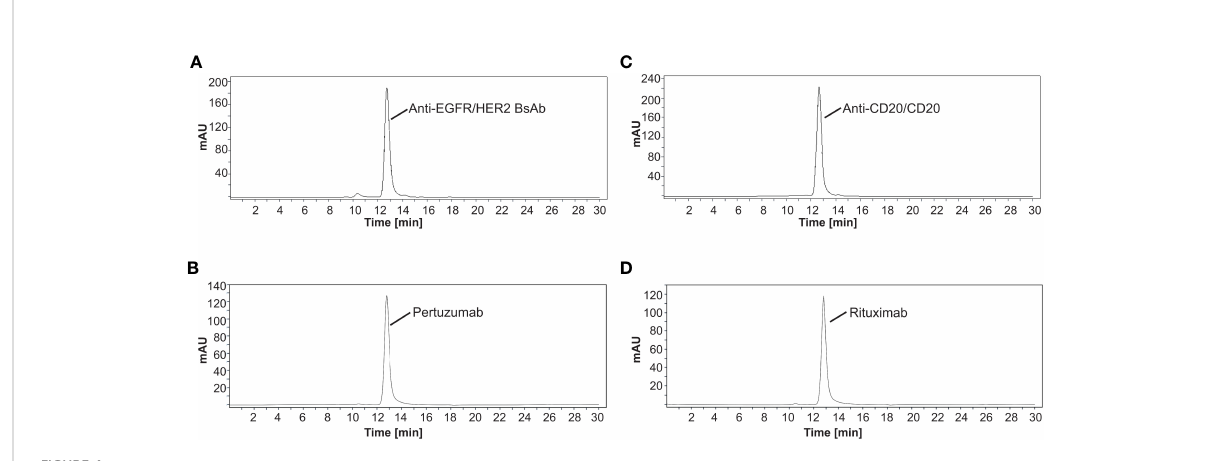
FIGURE 4 Separation of antibodies by size exclusion chromatography. The elution pro fi les showed a major peak of (A) anti-EGFR/HER2 BsAb, (B) pertuzumab, (C) anti-CD20/CD20 BsAb, and (D) rituximab with a retention time that is consistent with their expected molecular weight of around 144-145 kDa, respectively. All SEC experiments were done in triplicate. Chromatograms shown here are representative of the results.